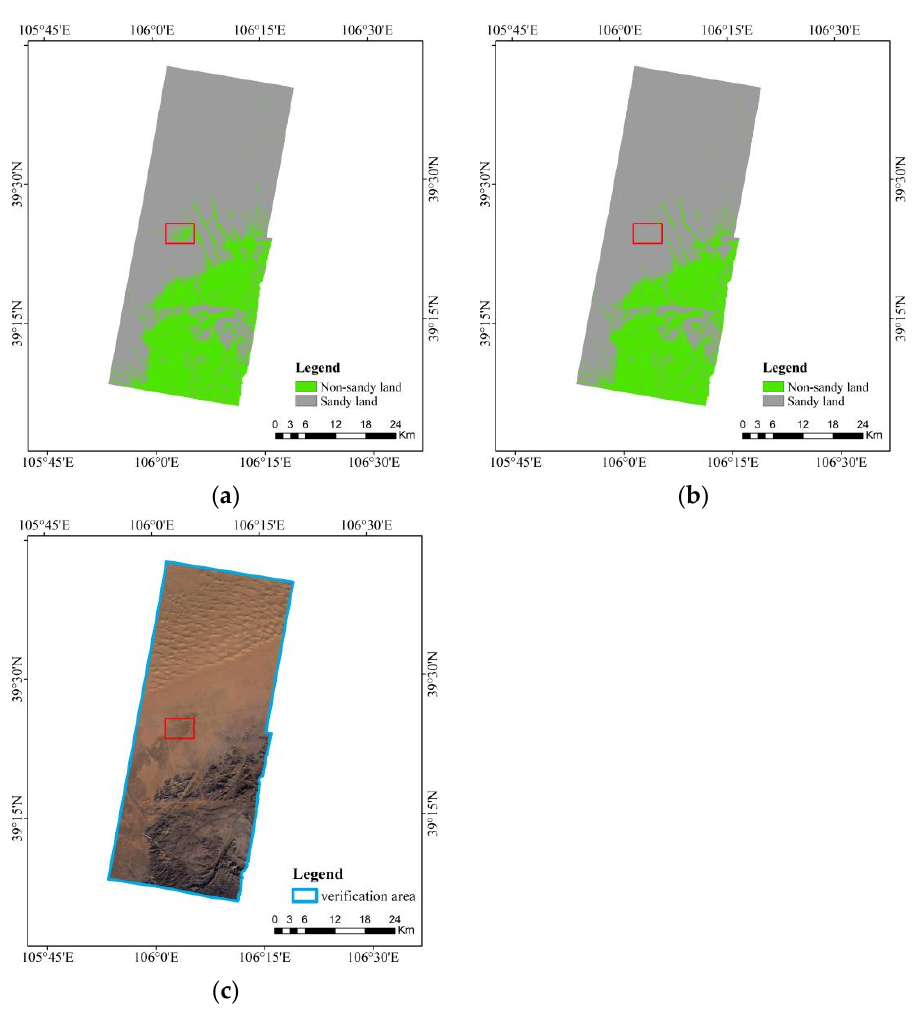
Figure 12. Sandy land detection in the verification area. ( a ) Sandy land detection based on single- sensor GF-3; ( b ) sandy land detection based on feature-level fusion; ( c ) HJ-2A hyperspectral image in the verification area. Table 7. The accuracy of sandy land detection in the verification area.